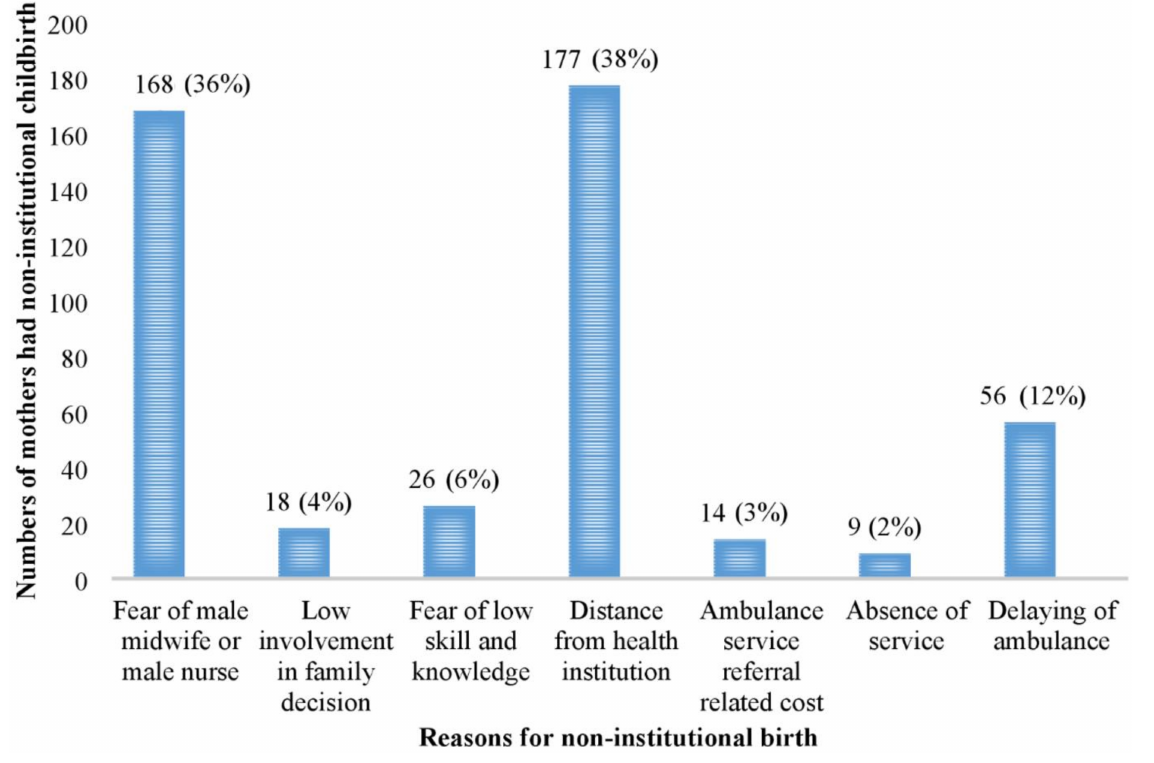
Figure 2. Respondents’ reasons for their non-institutional childbirths. Table 2. Plan for the place of birth service